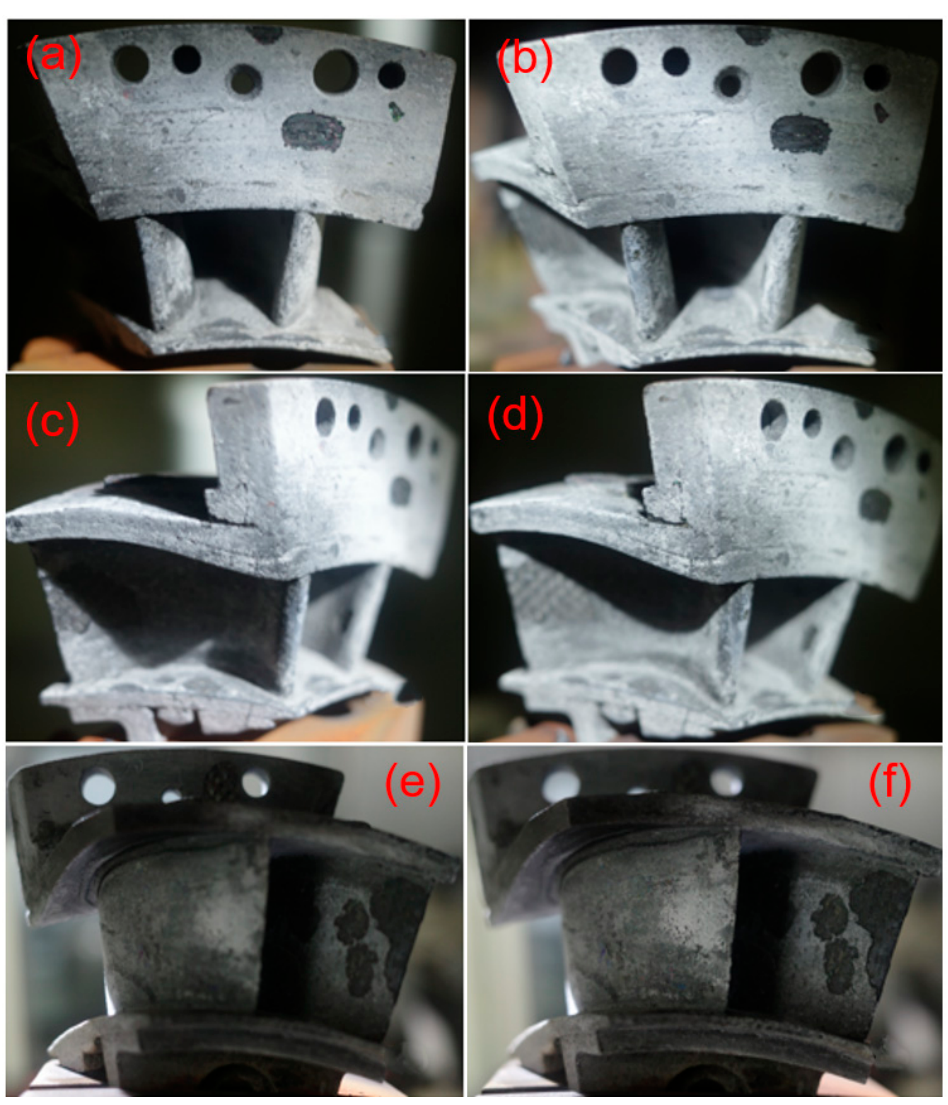
Figure 12. Thermal shock damage of SiC/SiC twin guide vane at target temperature of T = 1480 °C with the hold time of t = 30 s for leading edge at ( a ) N = 100, and ( b ) N = 200, the basin region at ( c ) N = 100, and ( d ) N = 200, and the back region at ( e ) N = 100, and ( f ) N = 200.